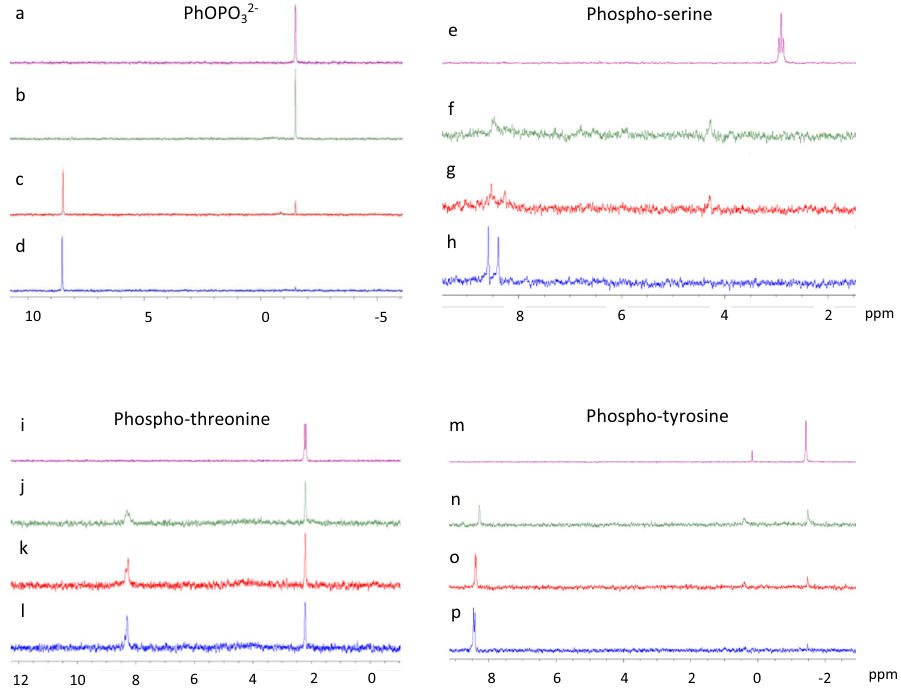
Fig. 4 Phosphatase activity of [L 2 Zn 3 ] 6 + . 31 P NMR spectra using different substrates including PhOPO 3 2 − (spectra a – d ), serine phosphate (spectra e – h ), threonine phosphate (spectra i – l ) and tyrosine phosphate (spectra m – p ). Speci fi c details for each 31 P NMR spectra are as follows: Spectra a , e , i and